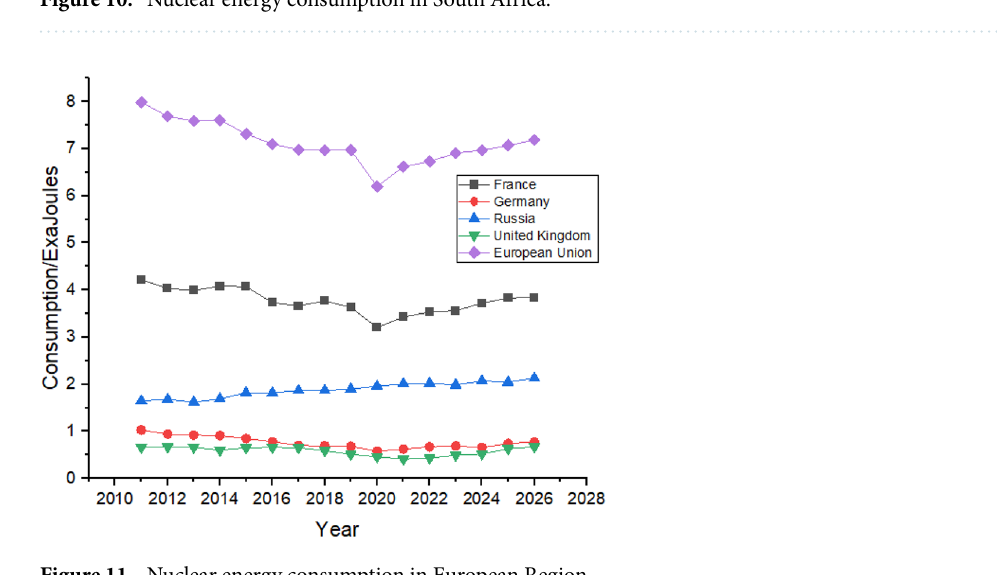
Figure 10. Nuclear energy consumption in South Africa.